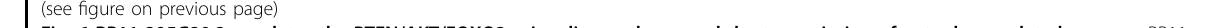
Fig. 6 RP11-295G20.2 regulates the PTEN/AKT/FOXO3a signaling pathway and the transcription of autophagy-related genes. a RP11- 295G20.2 regulates the phosphorylation of AKT. The phosphorylation of AKT was increased in RP11-295G20.2-overexpressing cells and decreased in RP11-295G20.2 knockdown cells. b , c RP11-295G20.2 regulates nuclear translocation of the FOXO3a protein. Nuclear translocation of FOXO3a was assessed by nucleo/cytoplasmic fractionation ( b ) and immuno fl uorescence staining ( c ) in RP11-295G20.2-overexpressing HCC cells. d RP11-295G20.2 regulates the transcription of autophagy-related genes downstream of FOXO3a. Quantitative PCR with reverse transcription (RT-qPCR) was used to determine the expression of autophagy-related genes in HCC cells following RP11-295G20.2 overexpression or knockdown. e , f The promotion of HCC cell growth by RP11-295G20.2 is mediated by PTEN downregulation. The decrease in HCC cell growth by RP11-295G20.2 knockdown is abrogated following PTEN knockdown ( e ). Promotion of HCC cell growth by RP11-295G20.2 overexpression is reversed after PTEN overexpression ( f ). g PTEN reverses the regulatory effect of RP11-295G20.2 on the PTEN/AKT/FOXO3a signaling pathway. h Schematic model of the mechanism by which RP11-295G20.2 induces PTEN degradation and regulates autophagy progression in HCC cells. * P < 0.05, ** P < 0.01, and *** P <